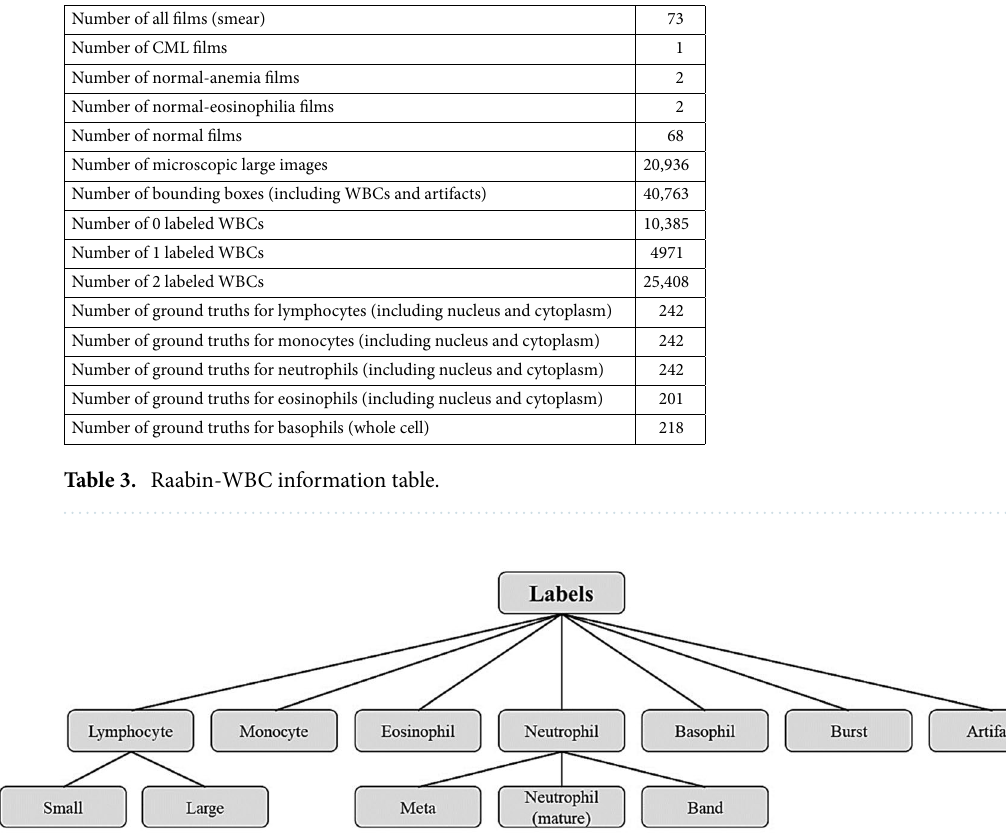
Figure 2. Diagram of labels in the Raabin-WBC